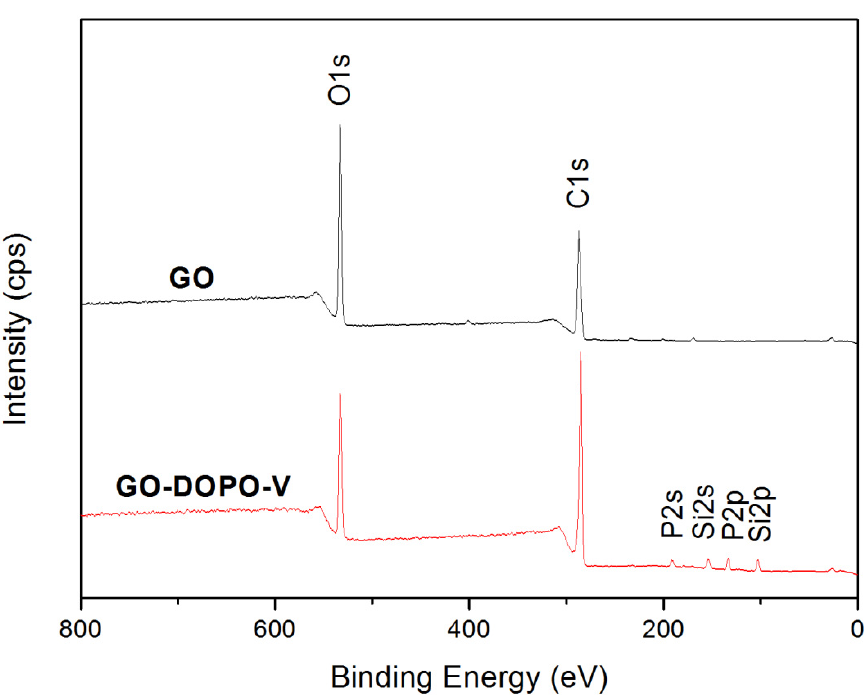
Figure 2. XPS survey spectra of GO and GO-DOPO-V.